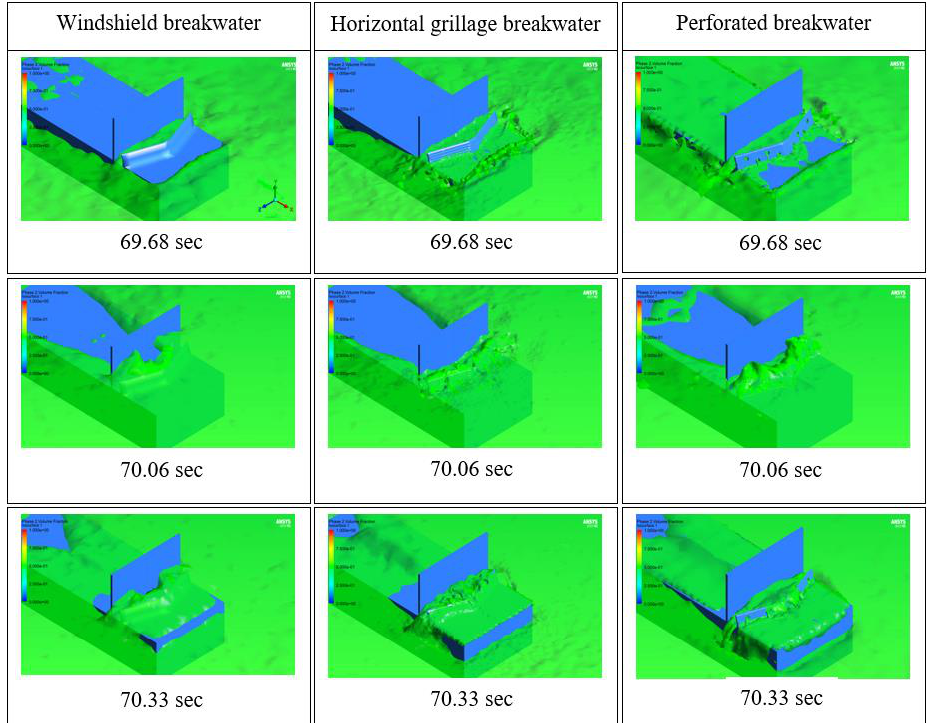
Figure 17. Greenwater splashing behaviour at various time instances for three breakwater designs.